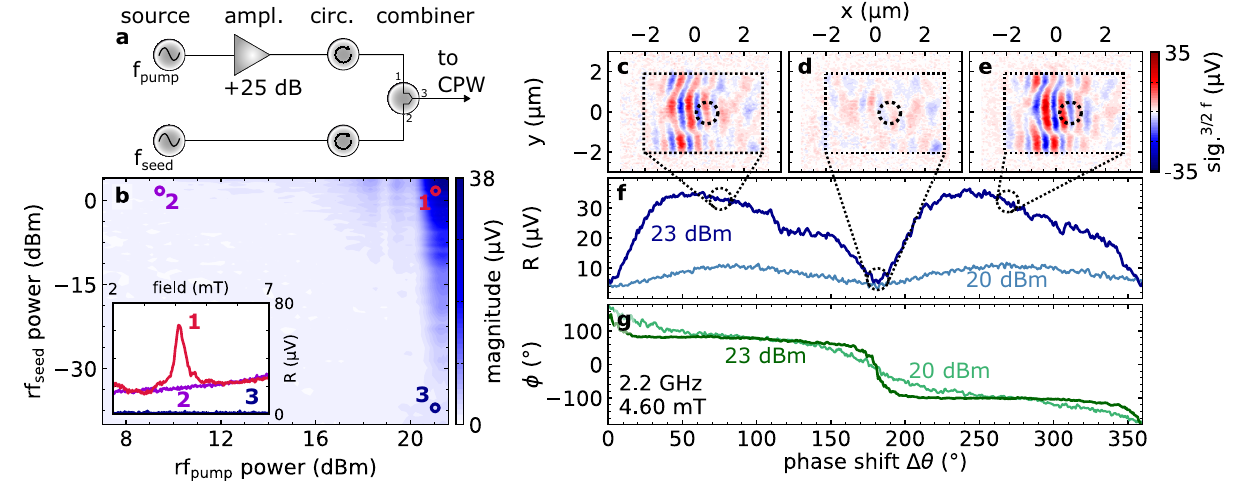
Fig. 5 | Phase-locking of NLSWs. a Modi fi ed excitation scheme for phase-locking experiments with additional seed frequency. b NLSW response as a function of pump and seed frequency power levels for a 5 μ m×4 μ m Ni 80 Fe 20 element. The inset shows three different regimes of power level combinations: (1) A signal trace at a large seed power level with a large pump power which contains NLSWs in red, (2) the off-resonant background due to direct excitations at 3/2 f rf with low pump powerinviolet,and(3)lowseedpowerandlargepumppowerinblue.Wesubtract